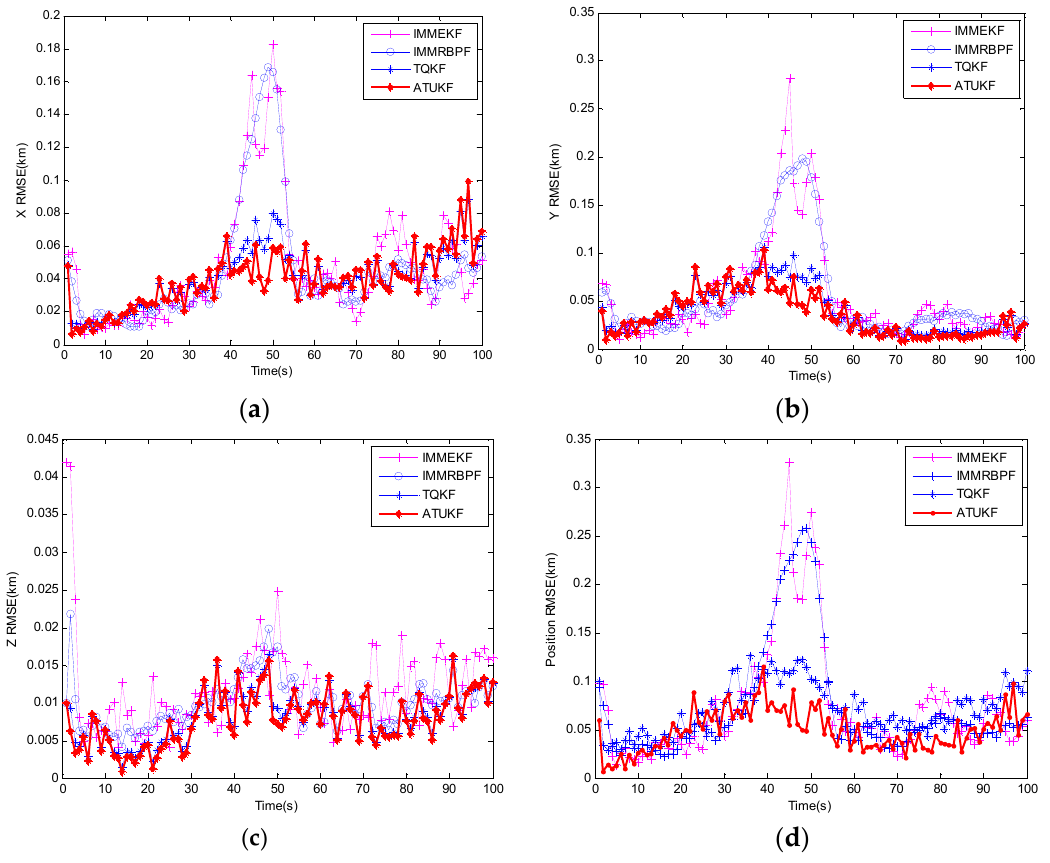
Figure 5. Root-mean-square error (RMSE) of the ATUKF, IMMEKF and IMMRBPF. ( a ) X RMSE; ( b ) Y RMSE; ( c ) Z RMSE; ( d ) position RMSE.